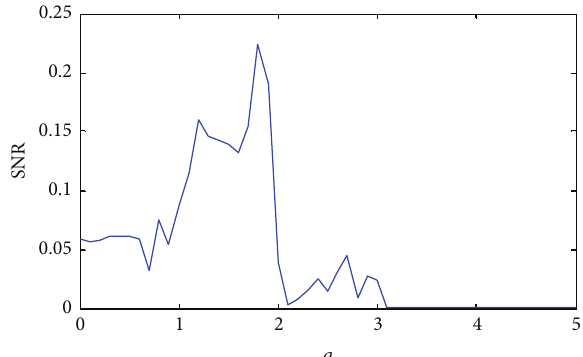
Figure 6: The variation curve of SNR while adjusting the system parameter 𝑎